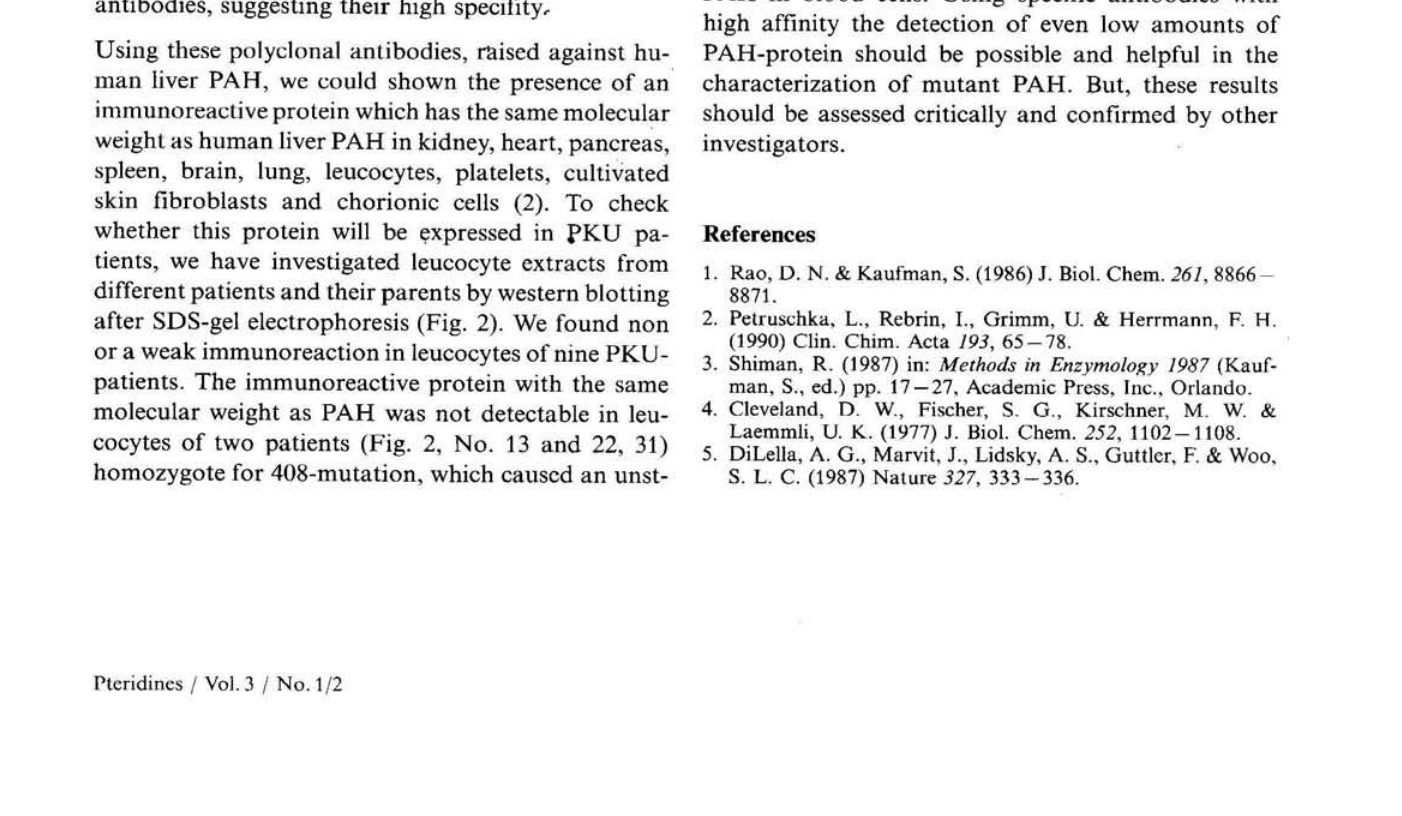
partially purified human kidney PAH for these ex- antibodies, suggesting their high specifity.